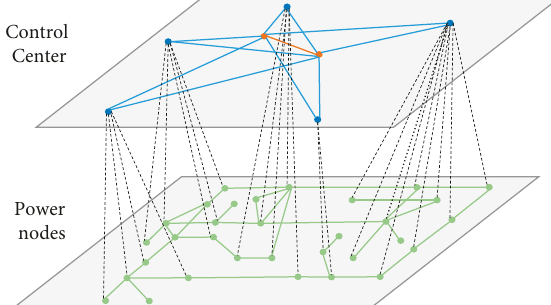
Figure 9: “Node to node” interdependent network of the local grid.